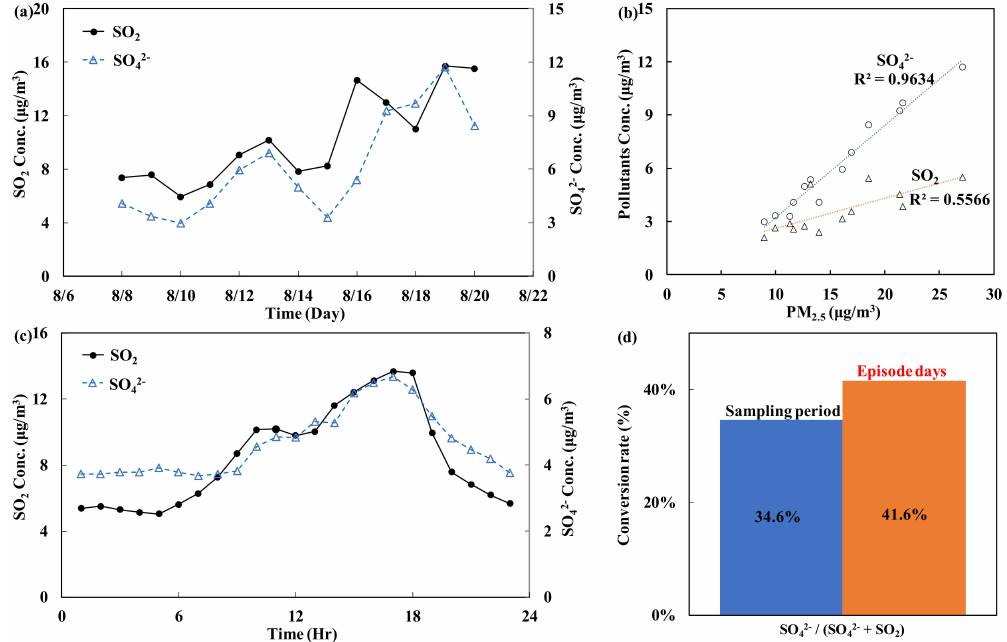
Figure 5. Trend in the daily and hourly average concentrations and conversion analysis of sulfur oxides: ( a ) daily average trend; ( b ) correlation with PM 2.5 ; ( c ) hourly average trend; and ( d ) conversion